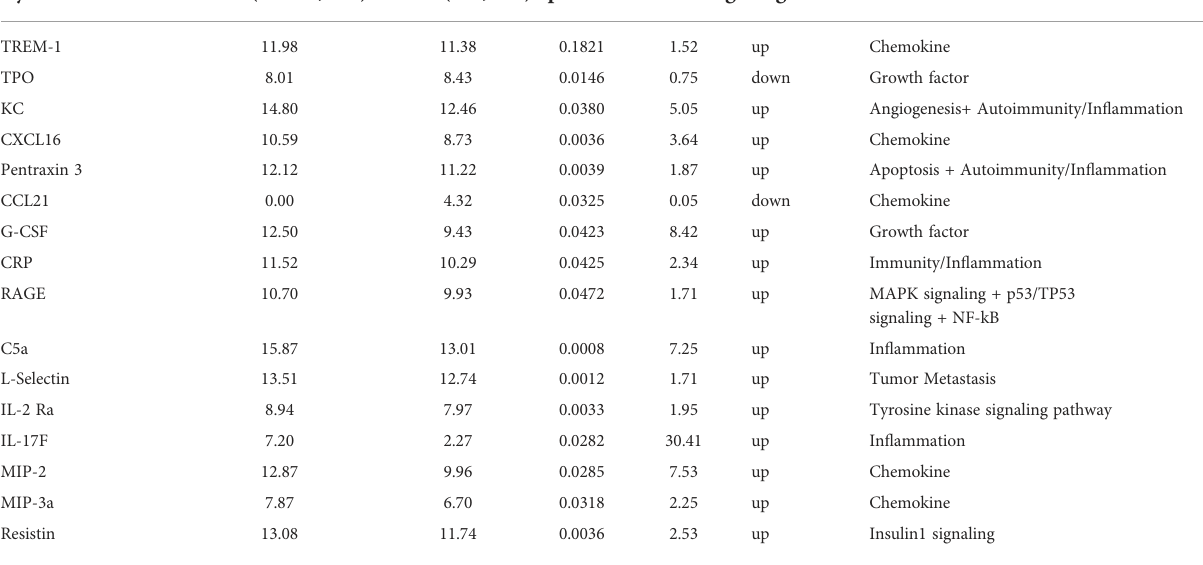
TABLE 1 The antibody array data of differentially expressed cytokines. Cytokine